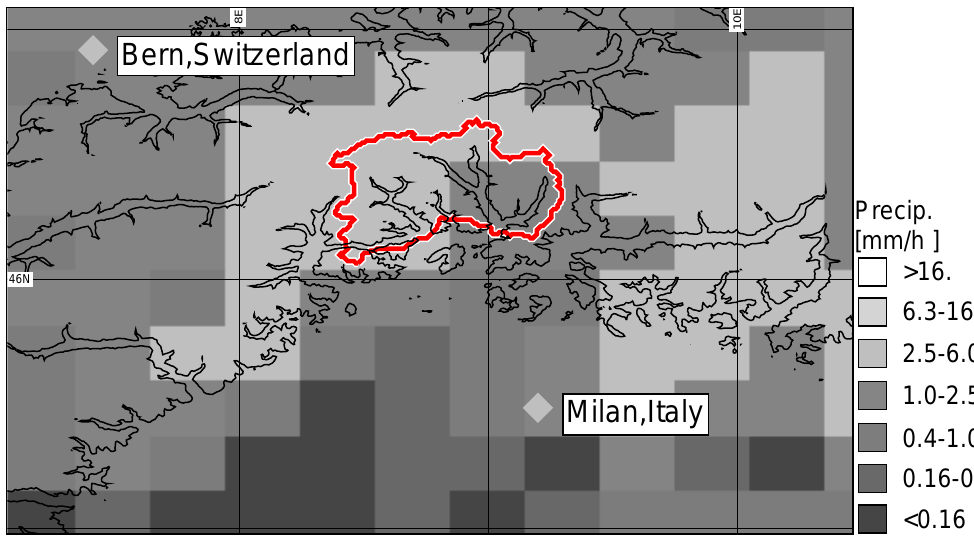
Fig. 1. Specification of areas of interests. The Ticino-Verzasca-Maggia (TVM) watershed (total area: 2627km 2 ) is outlined in red. The complex orography in the area is indicated by 1000m ASL thin isolines. Additionally, a precipitation analysis by Frei and H¨aller (2001) for the period 06:00UTC at 20 September 1999 to 06:00UTC the next day is shown. Grid spacing of the analysis is about 25km.